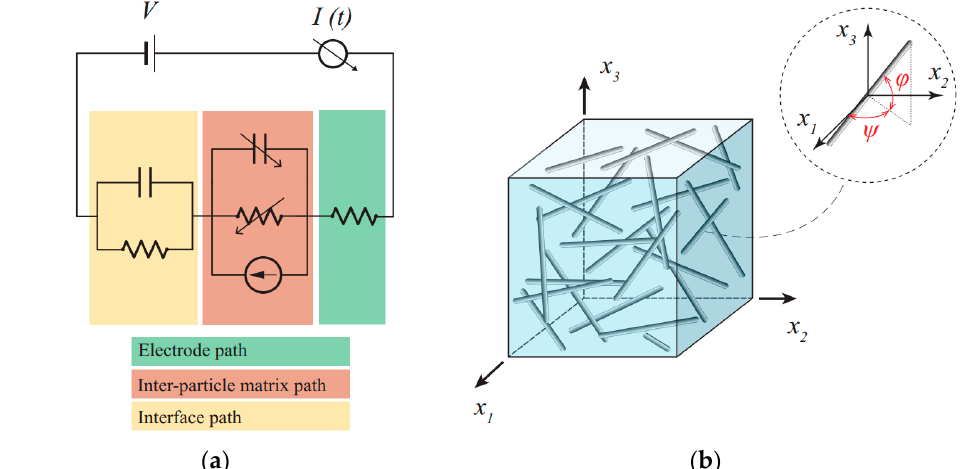
Figure 3. Modeling strategies for self-sensing structural materials: ( a ) Example of a lumped circuit model; ( b ) Sketch of a micromechanics modeling